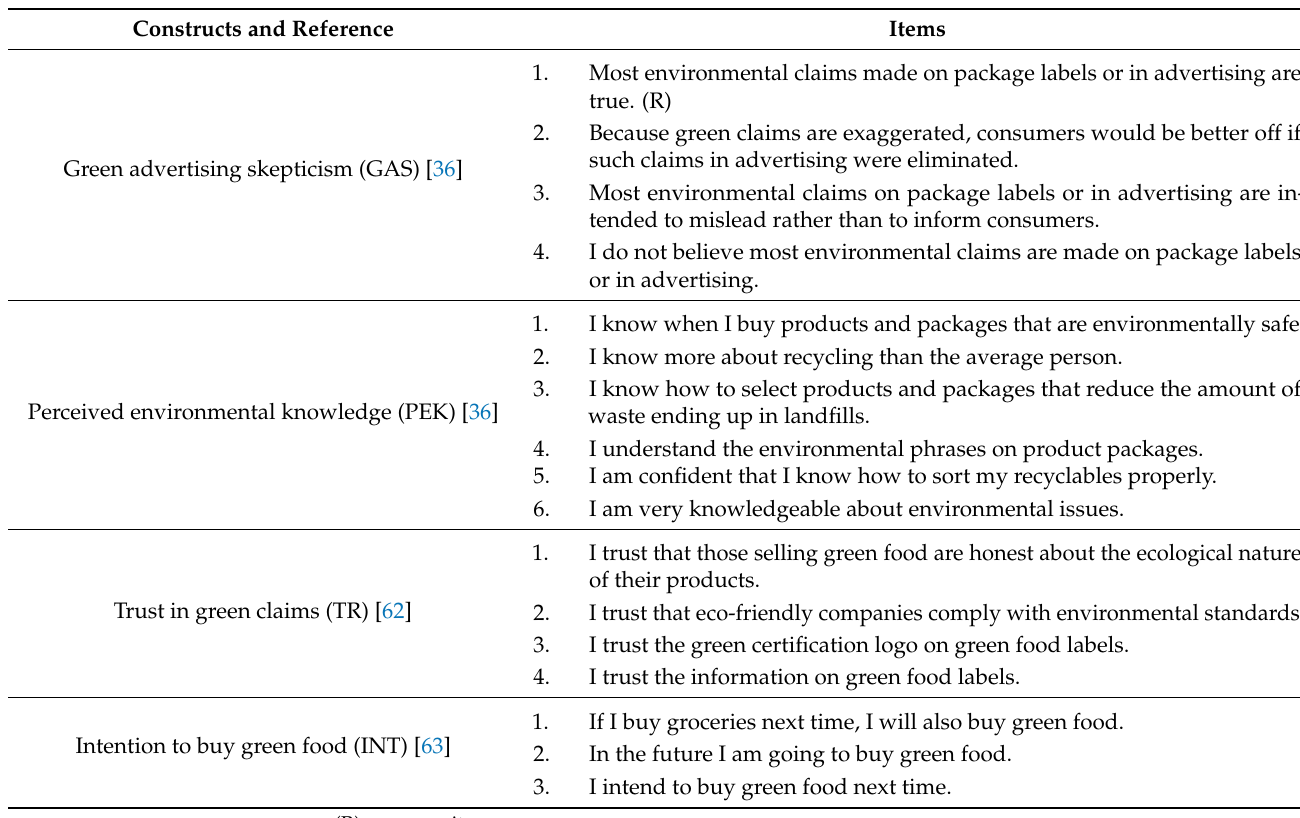
Table 1. Constructs, references, and items of